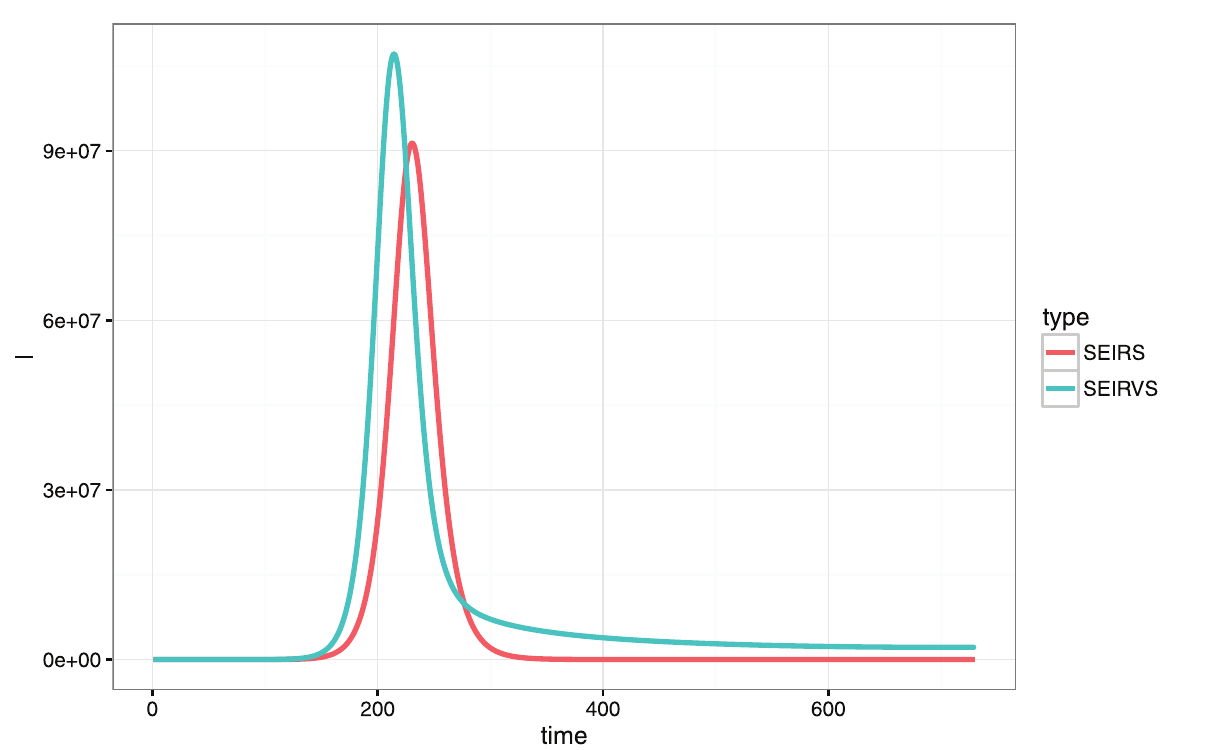
Fig 2. Simulated infection cases using SEIRVS and SEIRS